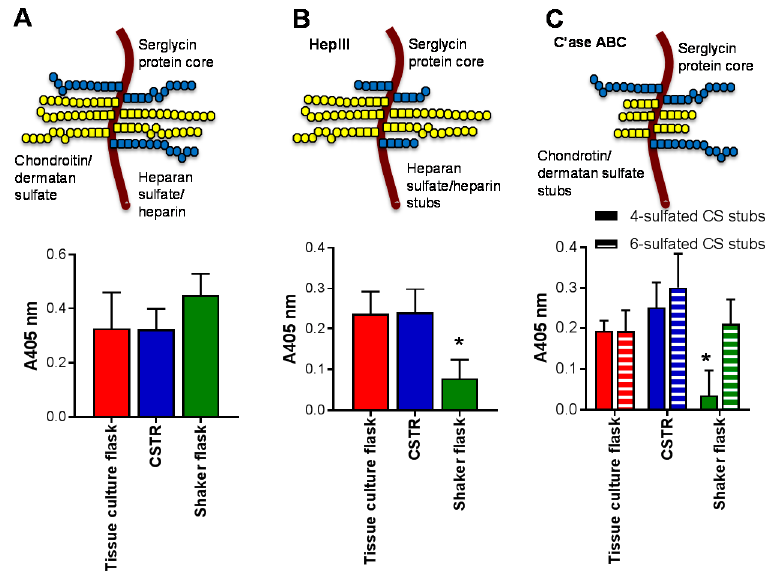
Figure 4. The effect of bioreactors on the production of serglycin, heparin/heparan sulfate and chondroitin sulfate. The schematic indicates the structure of serglycin with eight glycosaminoglycan attachment sites that can be decorated with either chondroitin/dermatan sulfate or heparin/heparan sulfate chains. The effect of glycosaminoglycan lyase digestion on the glycosaminoglycan chains are indicated in panels ( B , C ) with HepIII removing heparin/heparan sulfate chains to reveal a single stub structure and chondroitinase ABC (C’ase ABC) removing chondroitin/dermatan sulfate chains to reveal a stub structure. ELISA for the presence of (A) serglycin core protein; (B) heparin/heparan sulfate stubs detected using anti-heparan sulfate/heparin-stub antibody clone 3G10 following HepIII digestion, and ( C ) chondroitin sulfate stubs detected using anti-4-sulfated chondroitin sulfate stub antibody clone 2B6 and anti-6-sulfated chondroitin sulfate stub antibody clone 3B3 following C’ase ABC digestion. Data are presented as means ± standard deviation ( n = 3). * indicates significant differences ( p < 0.05) compared to tissue culture flasks analyzed by one-way ANOVA.